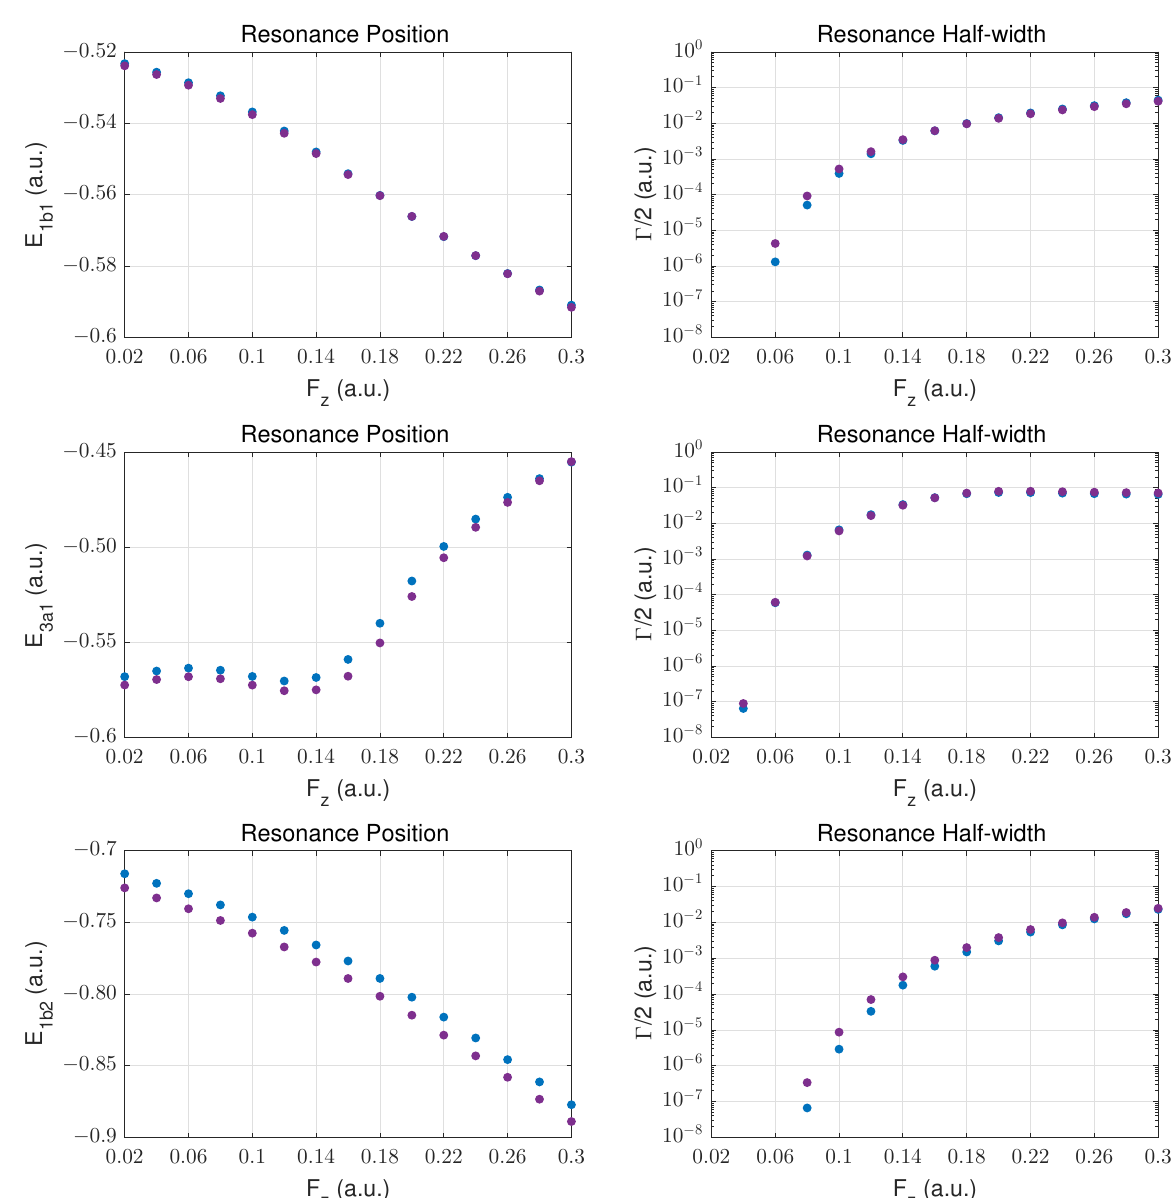
Figure 7. The left panel contains the resonance positions while the right panel contains half-widths for the valence orbitals of H 2 O in a dc field. Here, F z > 0 corresponds to a force experienced by the electron in the positive z direction. The (cid:96) max = 3 and (cid:96) max = 4 results are shown in blue ( • ) and purple ( • ),